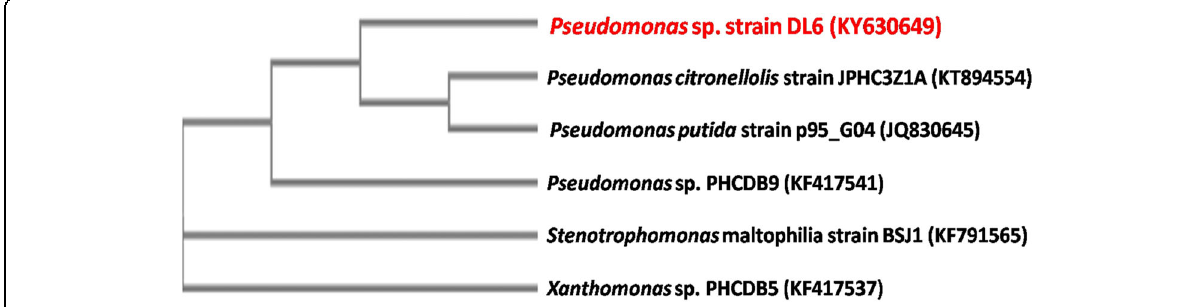
Fig. 3 Phylogenetic tree based on 16S rRNA gene sequences of DL6 bacterial strain and other closely related species on